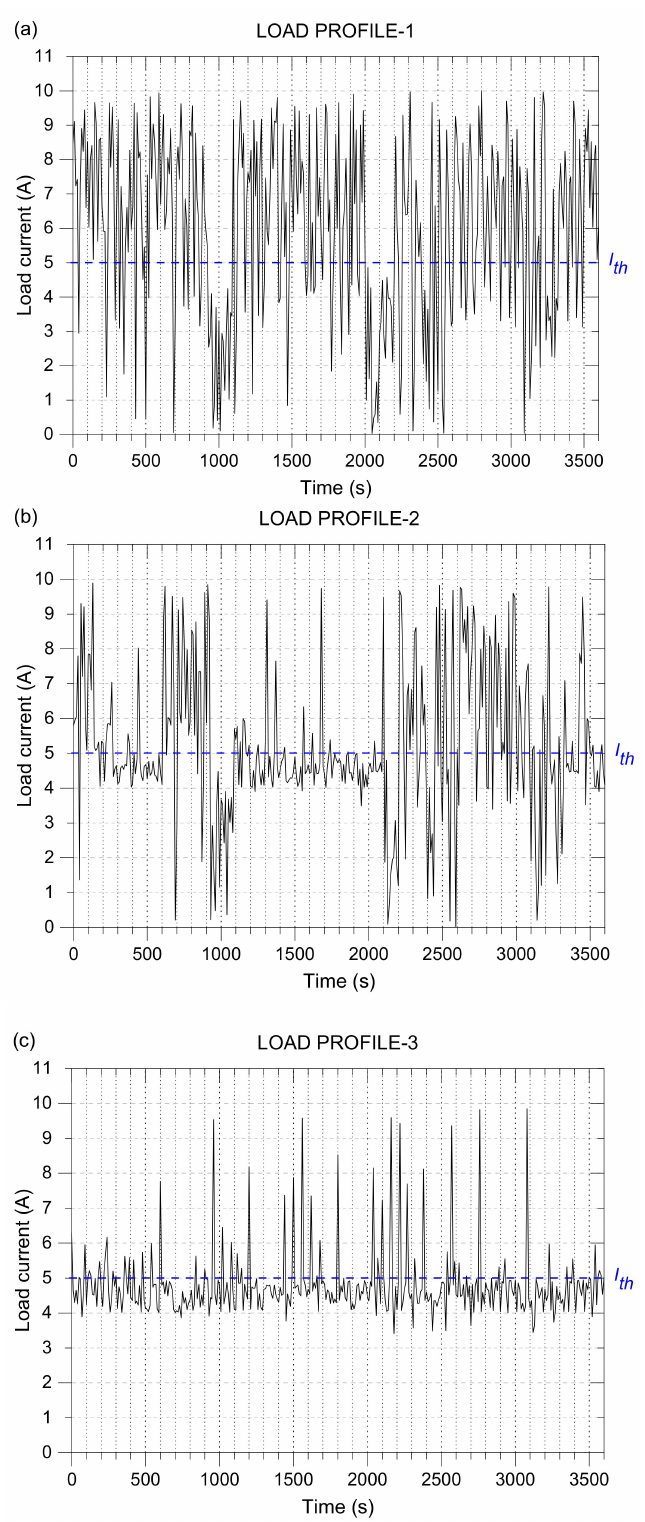
Figure 4. ( a ) Load profile 1 represents an urban electric bus (high power operation). ( b ) Load profile 2 represents an urban electric bus (high and nominal power operation). ( c ) Load profile 3 represents a mobile vaccination centre storage unit (nominal power